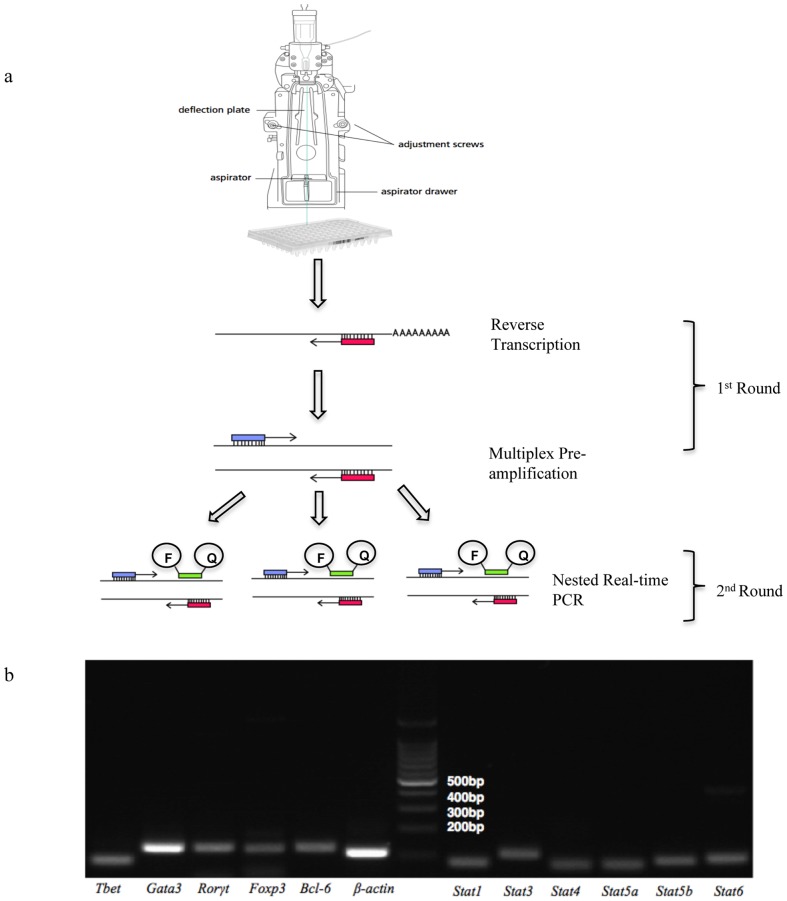
Overview of the qualitative multiplex single-cell RT-PCR and Primer Specificity.A) Single cells are sorted into individual wells in a 96 well plate. Binding of the gene specific 3′ primer to the mRNA allows reversed transcription to cDNA. This is then followed by 22 cycles of multiplex pre-amplification. The 1st round products are diluted 1/5 and then split for the 2nd round real-time amplification with nested 5′ and 3′ primers, and specific amplification was detected with the addition of specific LNA probes (F = FAM, Q = Quencher). B) Specificity of all 11 TF and ß-actin (positive signal control) was examined by electrophoresis in 1.5% Agarose gel, to determine correct sized amplicons (for amplicon sizes refer to Supplementary). Real-time PCR was subsequently used to confirm specificity by checking single melt peaks using SYBR®-green I.